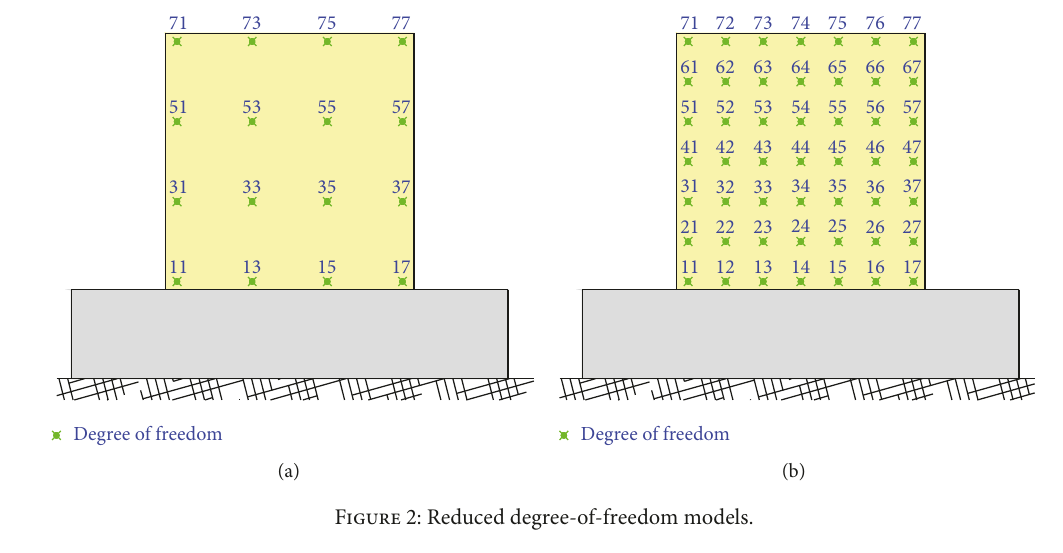
Figure 2: Reduced degree-of-freedom models.